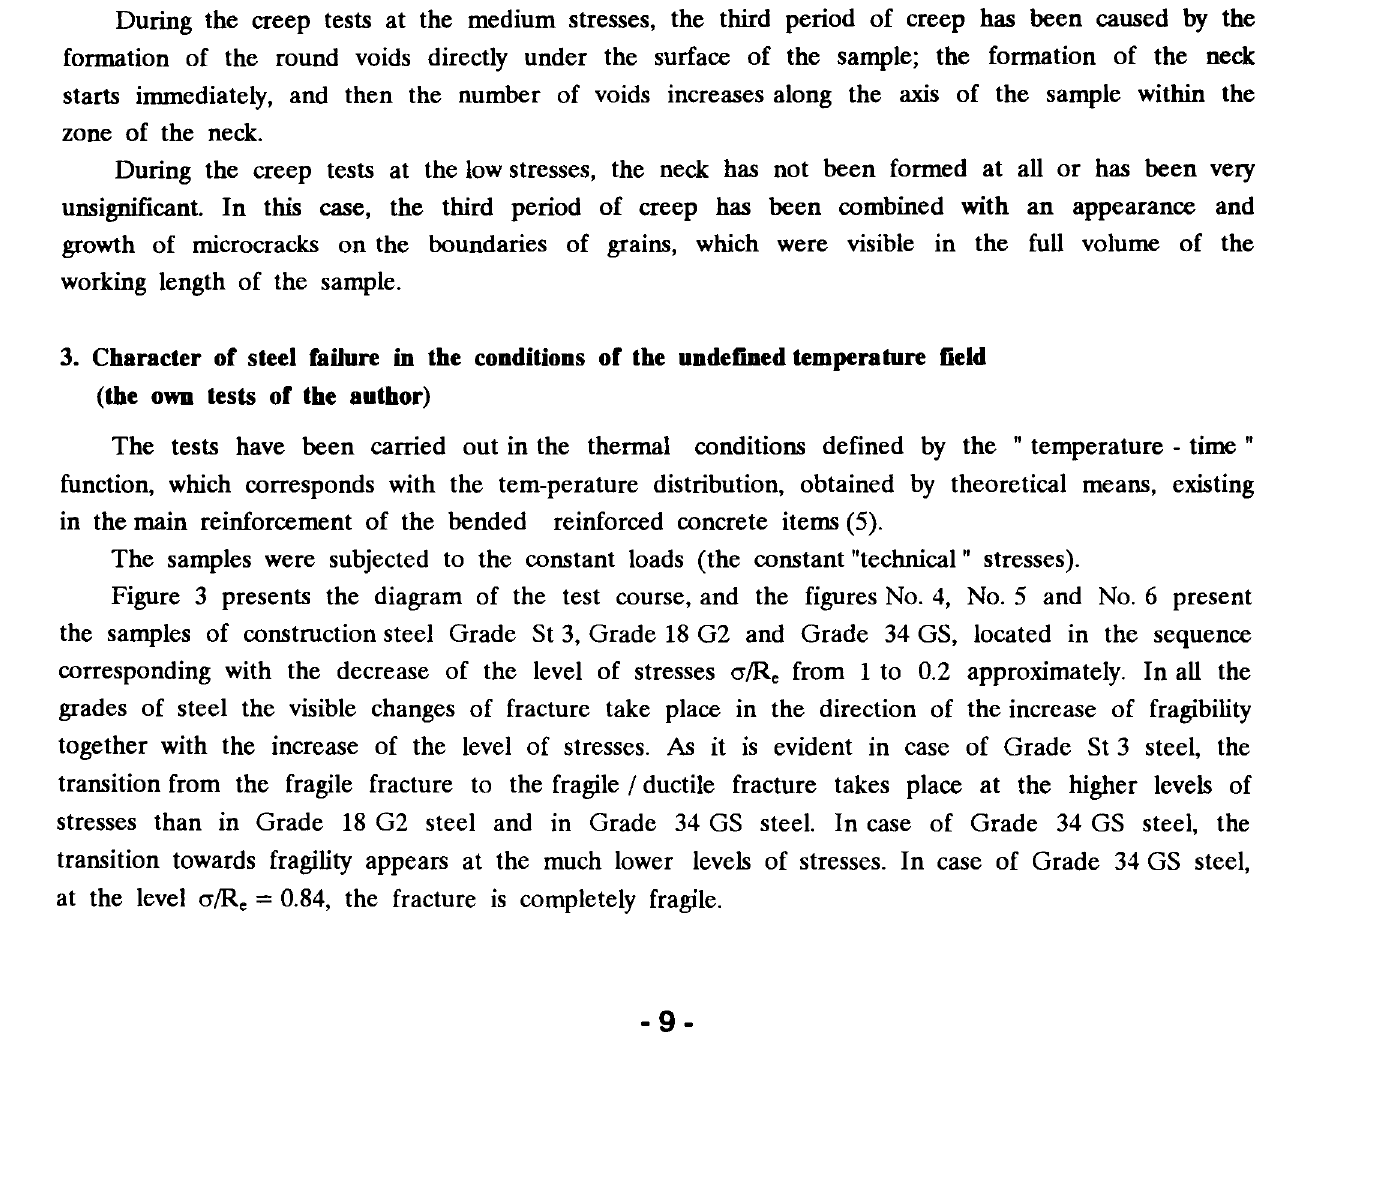
Fig. 2. Character of failure of the stainless steel samples (10% Cr, 95% Ni) in raised and high